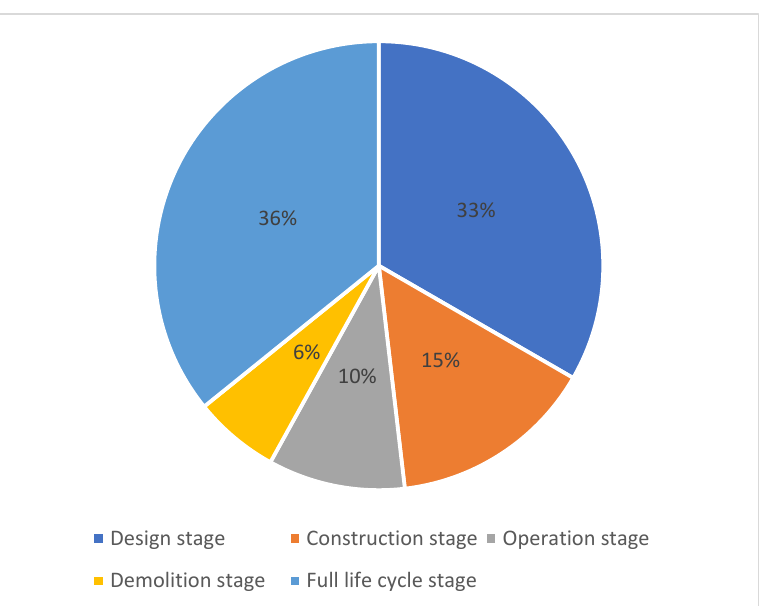
Figure 8. Weighting of publications in the field of BIM and carbon emissions for sustainable building during the building lifecycle for microqualitative analysis (generated by the authors).